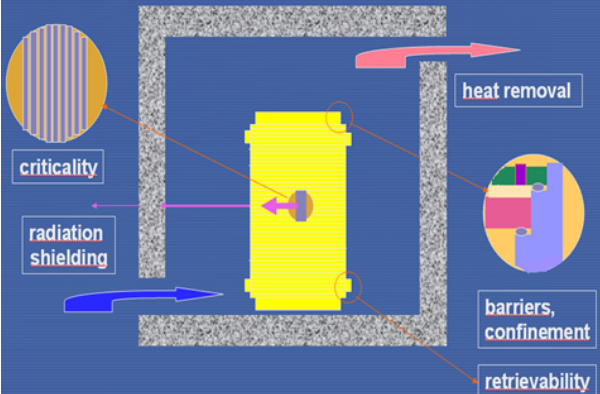
Figure 1. Five fundamental safety functions of the dry storage casks as defined by the State O ffi ce for Nuclear